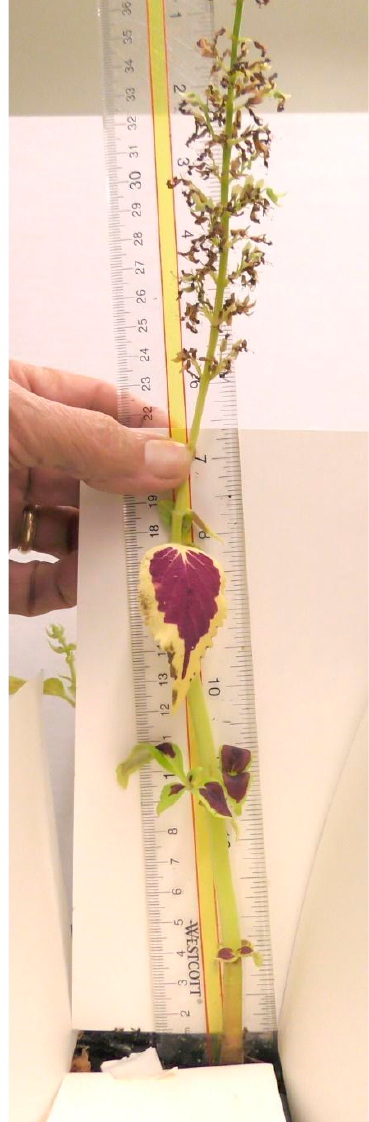
Figure A4. Coleus scutellarioides.